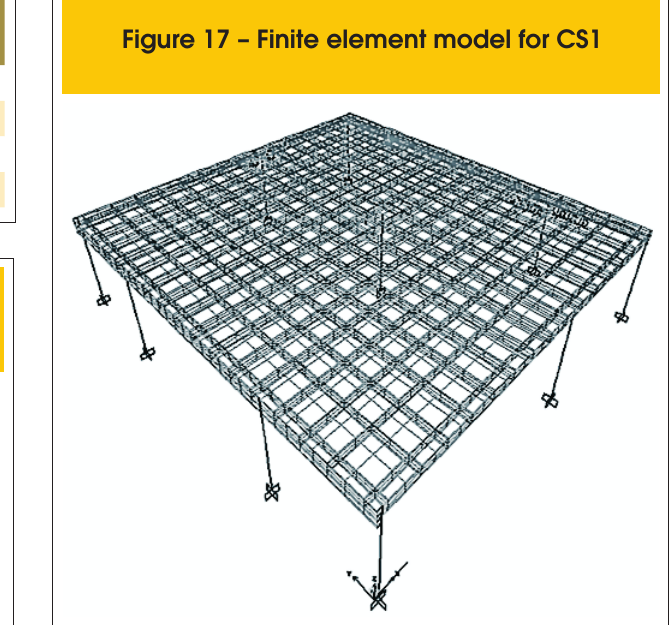
Figure 17 – Finite element model for CS1